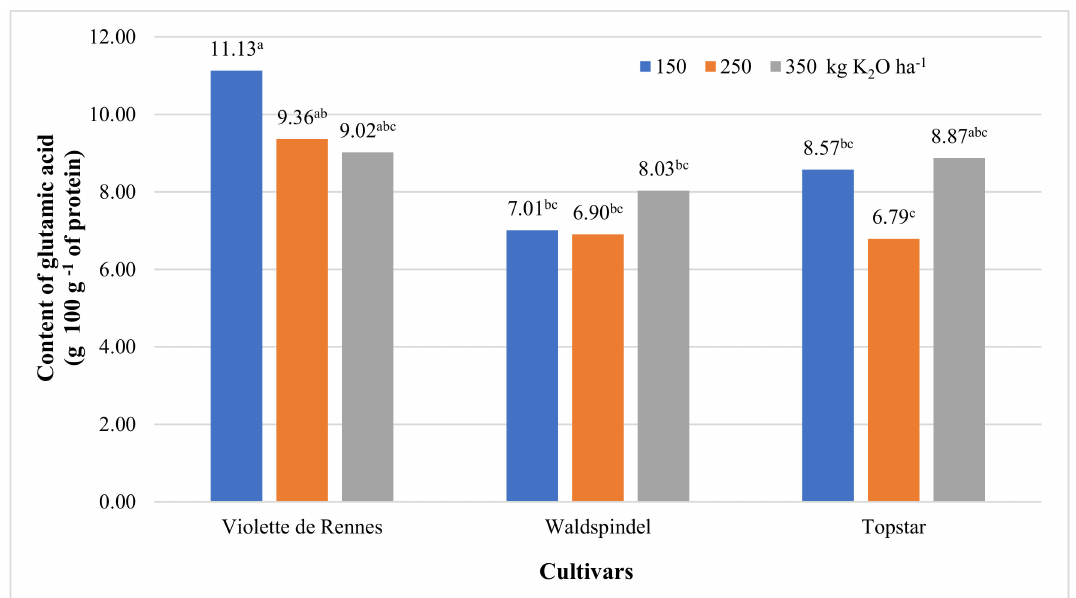
Figure 3. The e ff ect of potassium fertilization on the glutamic acid content of tubers in the analyzed Jerusalem artichoke cultivars. Means with the same letters do not di ff er significantly at p ≤ 0.05 in Tukey’s test. The absence of letters denotes non-significant main e ff ects.